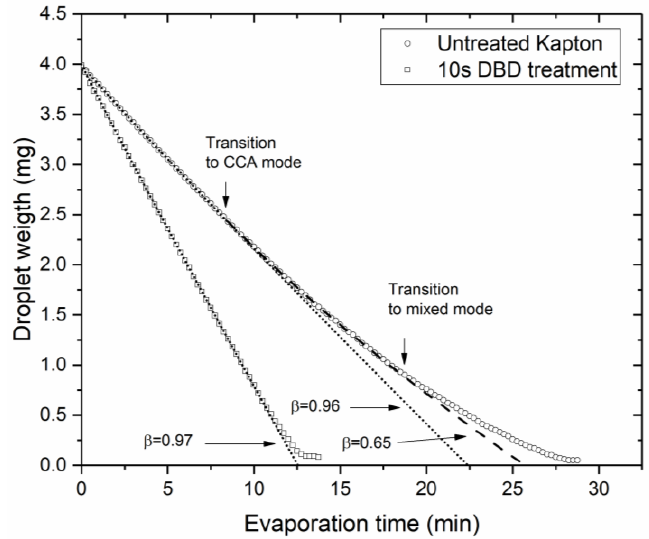
Figure 7. Mass of the droplet versus evaporation time.